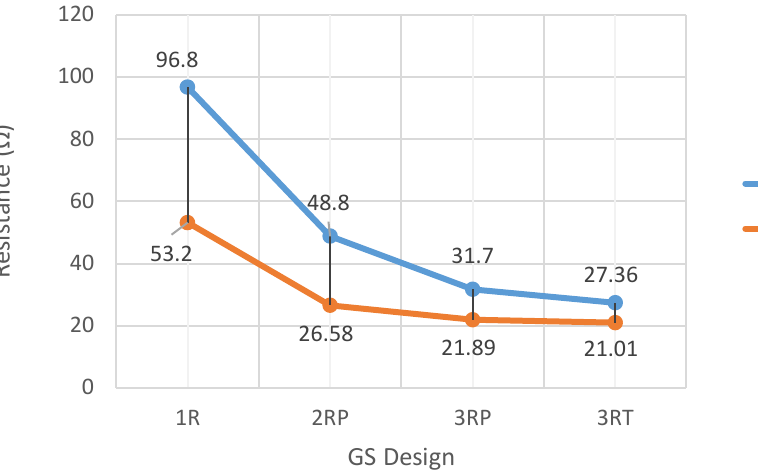
Figure 17. GR vs. GS design in S7.